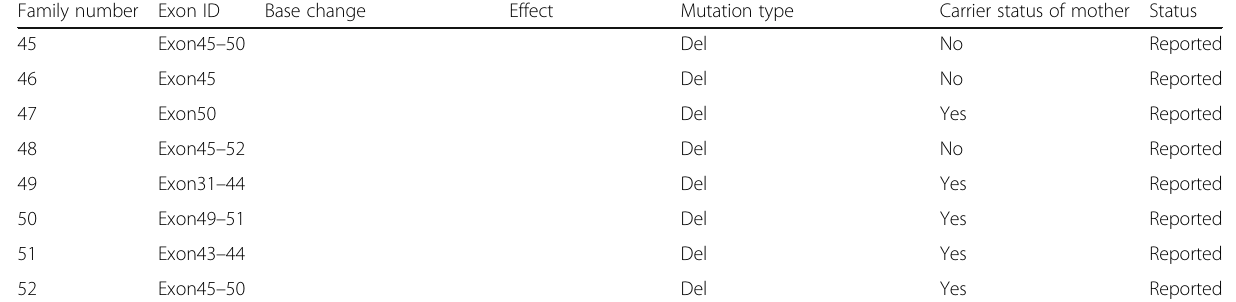
Table 1 The mutation spectrum of DMD patients in 52 families (Continued)